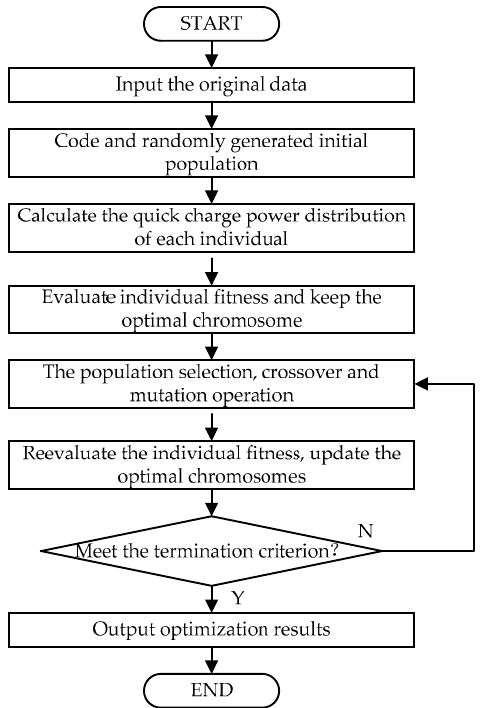
Figure 2. Flow chart of genetic algorithm for solving the single-target programming problem.